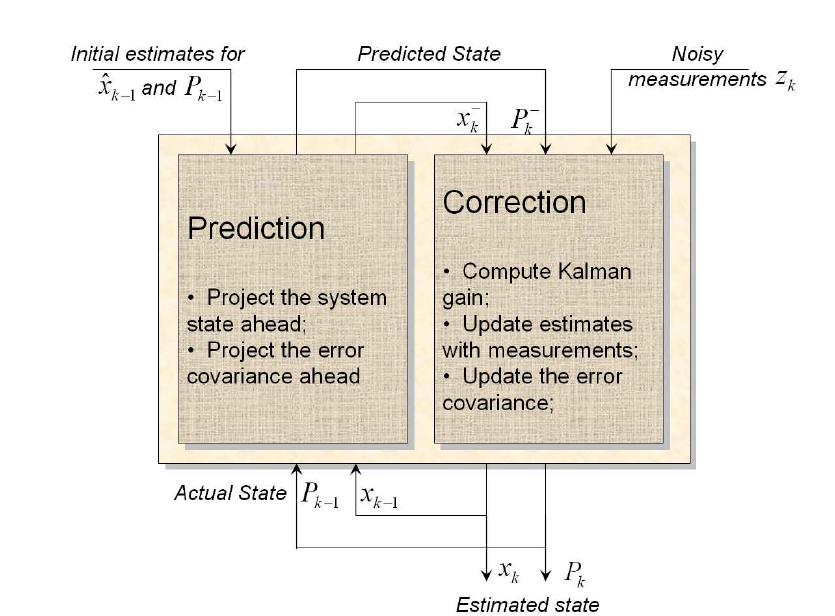
Figure 4. General prediction-correction structure of Kalman